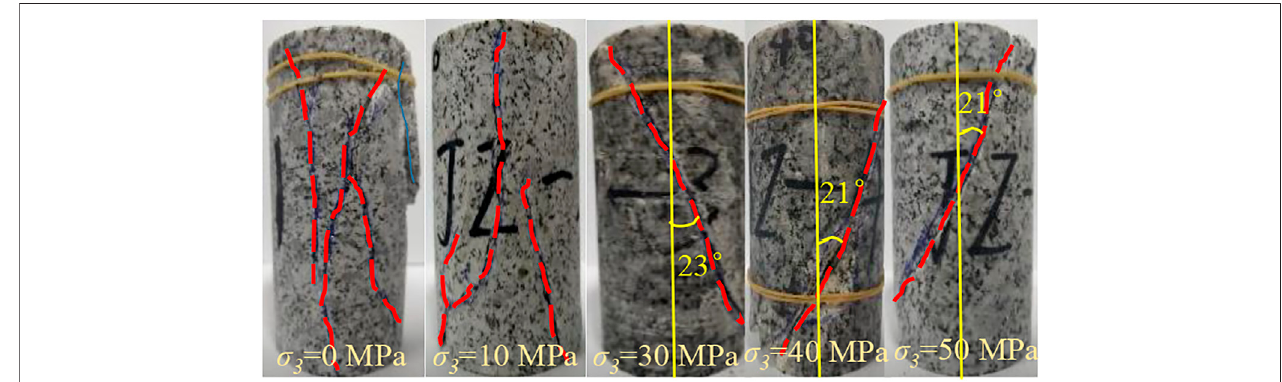
FIGURE 5 | Failed rock samples in compression tests.